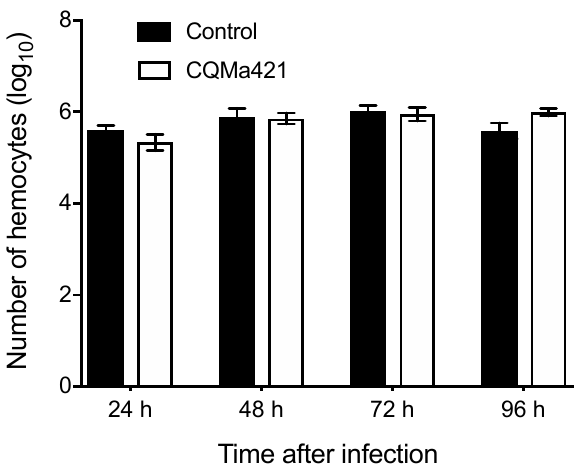
Figure 2. Concentration of hemocytes after challenge with M. anisopliae CQMa421 from 24 to 96 h. The bars represent the means ± SEs.